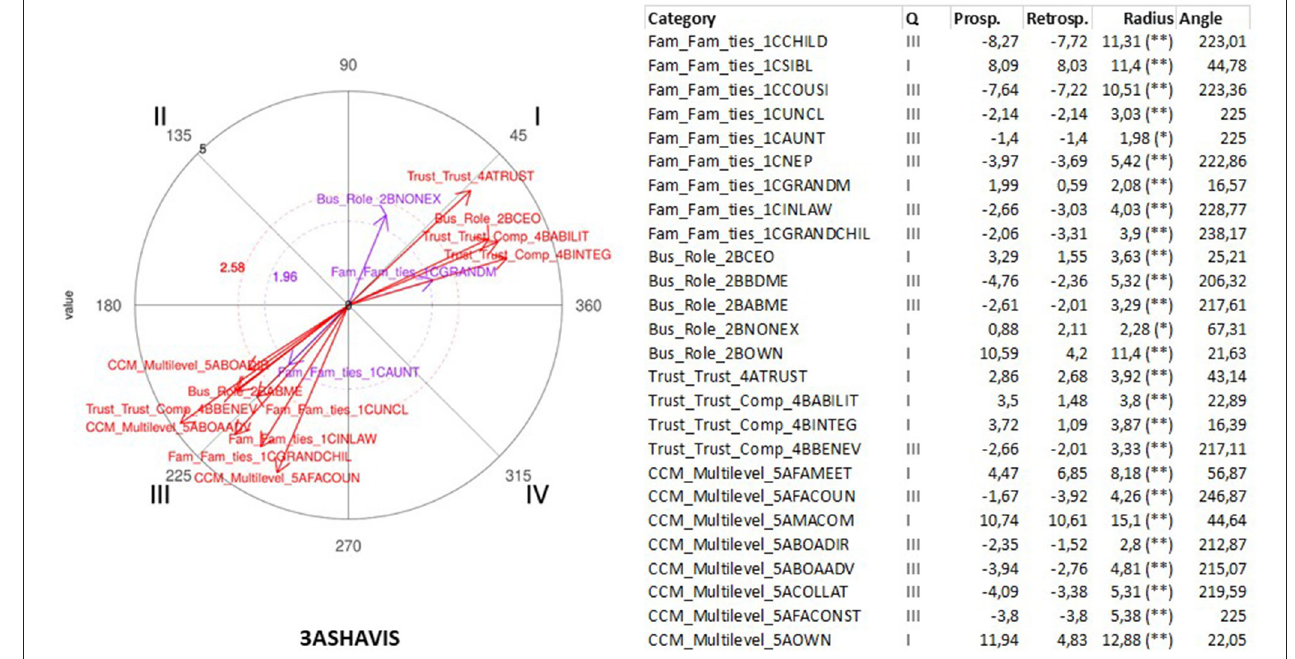
FIGURE 4 | Example A of vectorial map of the statistically significant relationships. The cart shows the vectorial map of the statistically significant relationships for the category of shared vision (3ASHAVIS) considering as focal behavior, and family boundaries (1A), generation (1B), family ties (1C), business roles (2B), trust (4A), components of trust (4B), lack of trust (4C), multilevel system (5A), perceived conflict (5B), types of conflict (5C), processes (5D), third-party assistance (5E), succession (5F), innovativeness (6A), risk-taking orientation (6B), and decision-making pace (6D), as conditional behaviors. At the table the results of the polar coordinate analysis are presented. The significance level was fixed at * p < 0.05 and ** p <